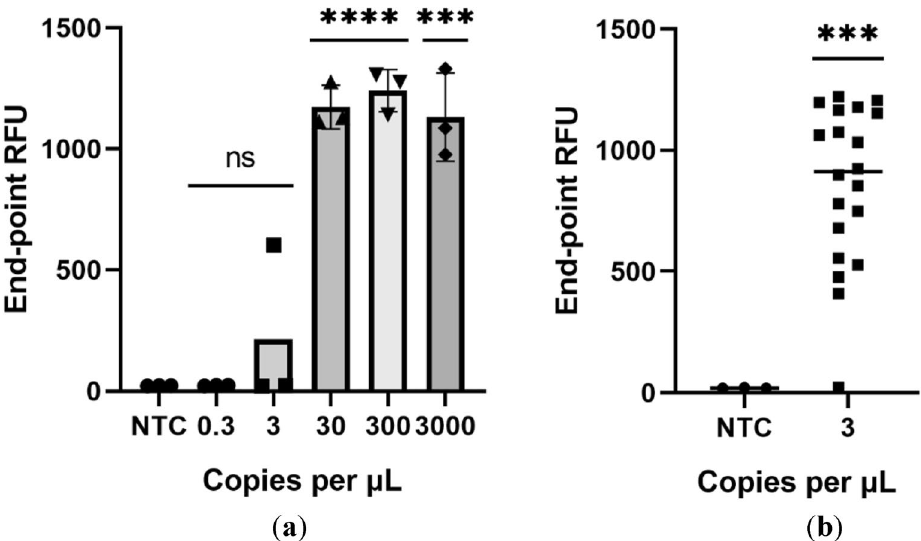
Figure 5. Limit of detection using the 2 step RT-LAMP/Cas12a reaction as recommended by the FDA. ( a ) End point detection of the different synthetic viral loads. ( b ) 20 replicates at this concentration revealed the detection of 19/20 indicating that this is the number of copies that is detected 95% of the time and thus our limit of detection. Statistical significance was determined by unpaired two-tailed t-test and all data were shown as mean ± S.D of 3 replicates. Asterisks indicate **P < 0.01; ***P < 0.001; ****P < 0.0001 and “ns” is non-significant.